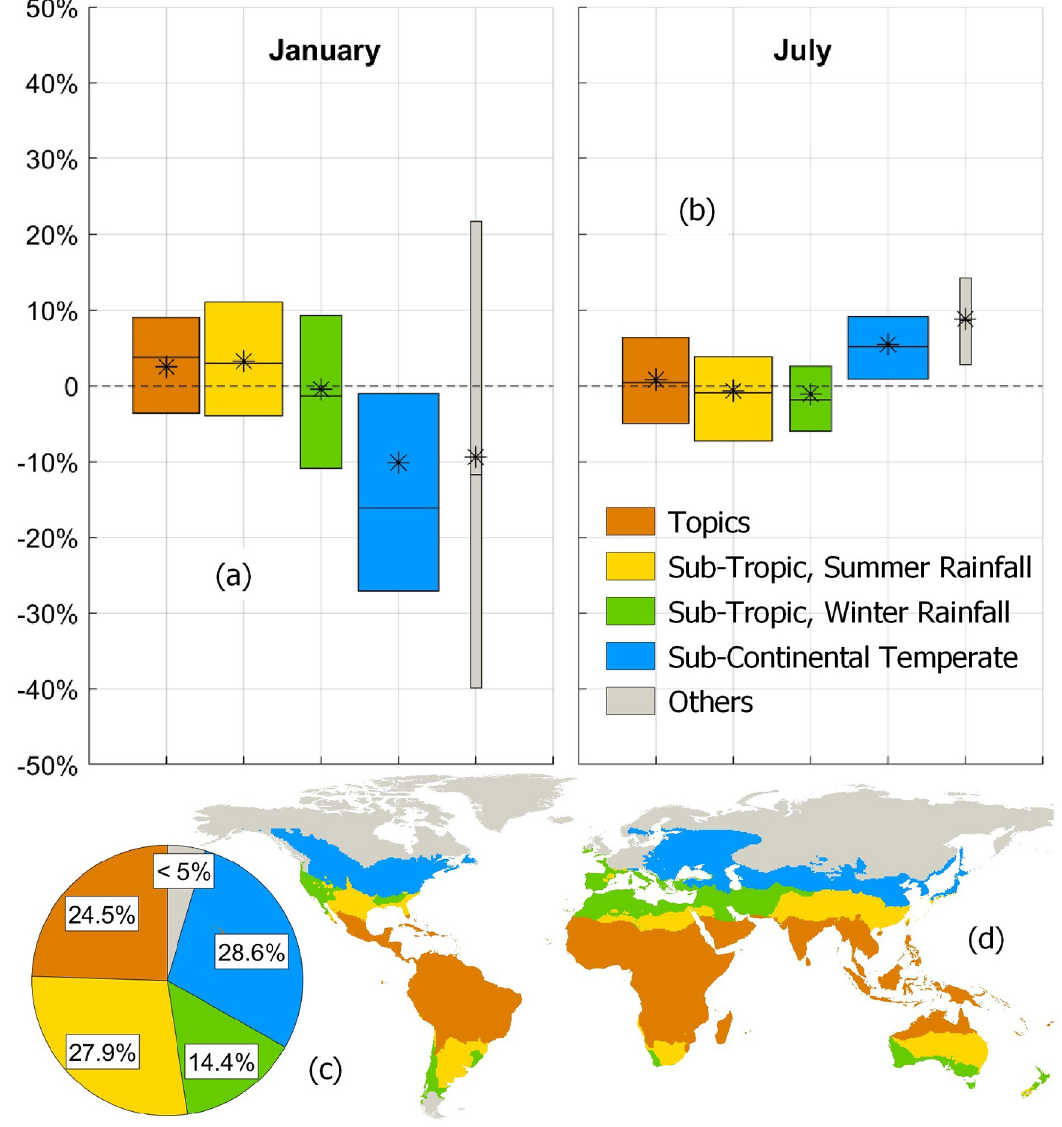
Fig 2. Boxplots and area-weighted means of percentage differences between monthly ET 0 (Computed HS and PM from CRU-TS). Boxplots show values corresponding to 25%, 50% and 75% of harvested lands for six climate zones: Tropics (orange), Sub- tropics summer rainfall (yellow), Sub-tropics winter rainfall (green), Temperate sub-continental (blue). The grey boxplot describes alignment over the least irrigated zones: Oceanic Temperate, Continental Temperate, Oceanic Boreal, Sub-Continental the ET 0 Boreal, Continental Boreal, Arctic. The horizontal dimension of the boxplot is proportional to the percentages of irrigated areas per climatic region, reported in the pie chart (c). Asterisks: area-weighted means of annual percentage differences. Fig 2d shows the GAEZ global agro-climatic classification of surface lands.